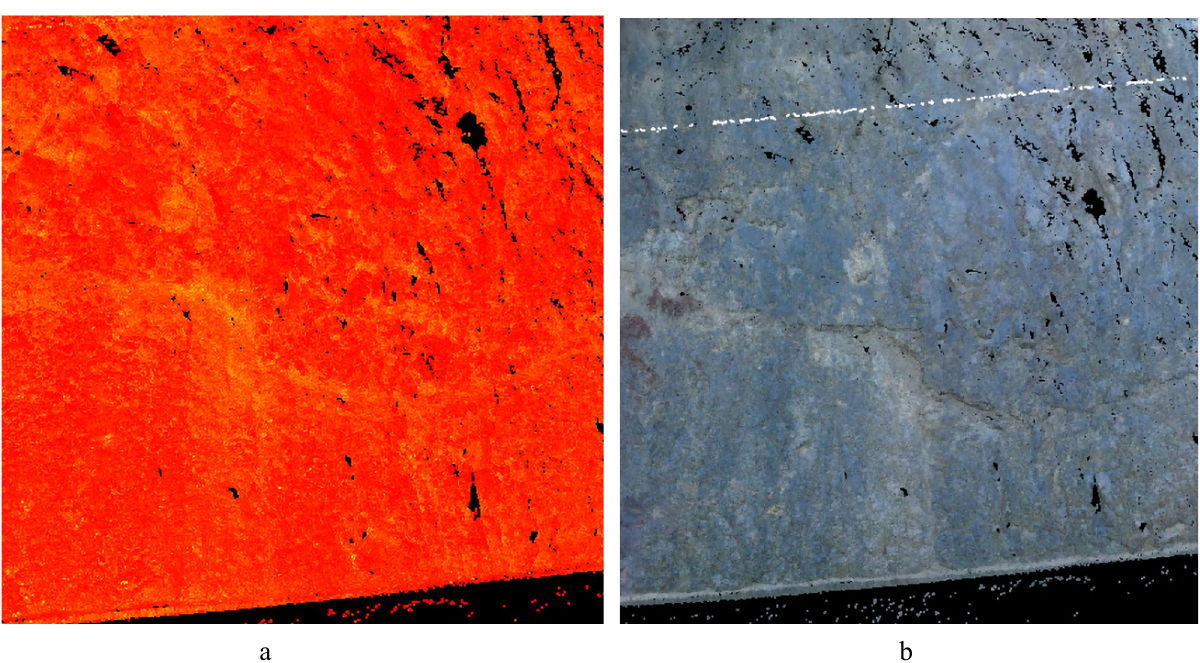
Figure 8. Comparison before and after point cloud coloring. ( a ) Original point cloud data. ( b ) Colored point cloud